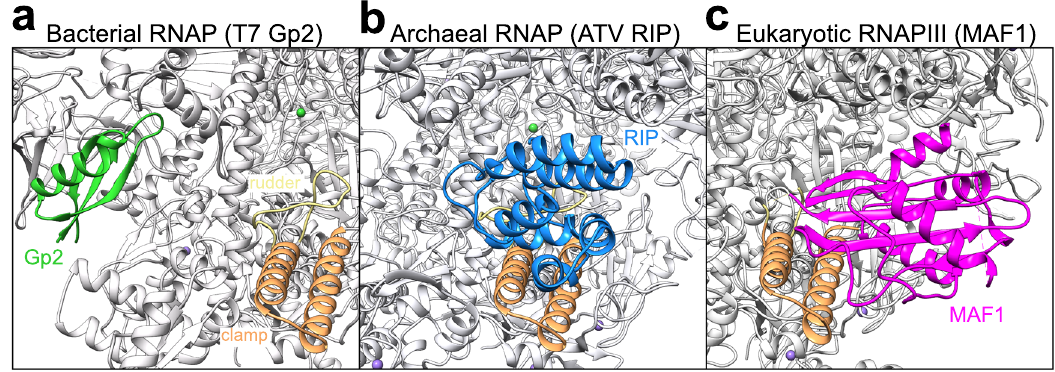
Fig. 6 The DNA-binding channel is a common target for transcription inhibition in all domains of life. The structures of the RNAP from a E. coli (pdb code 4lk0 6 ), b S. acidocaldarius , and the c S. cerevisiae RNAPIII (pdb code 6tut 36 ) are all shown in grey ribbons with the clamp and rudder highlighted in light orange and yellow, respectively. a The viral inhibitor T7 Gp2 is shown in green, b RIP from ATV in blue, and c the cellular negative regulator MAF1 in